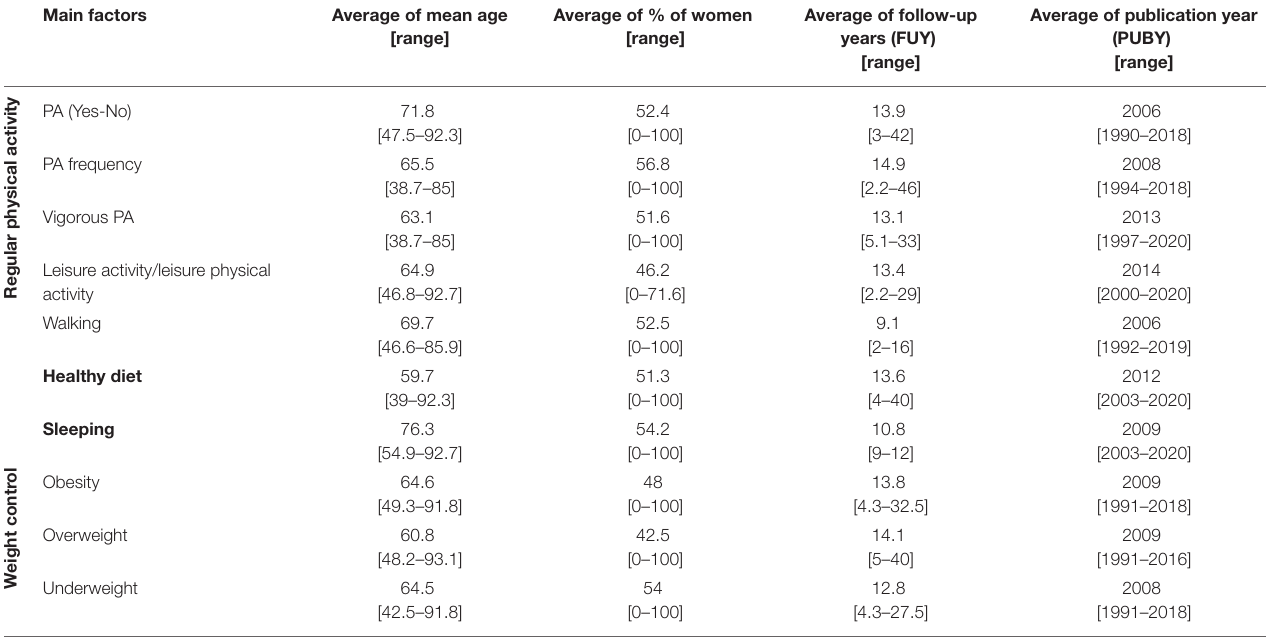
TABLE 1 | Means values (and range) in the four moderators studied, grouped according to the factors assessed. Main factors Average of mean age